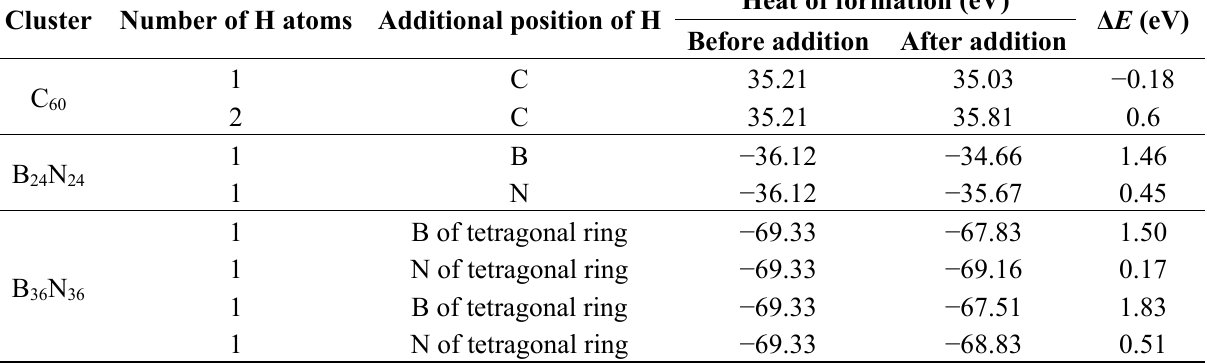
Table 3. Chemisorption energy of hydrogen (H) atoms on C 60 and B 24 N 24 . Δ E = (Heat of formation after hydrogen addition) − (Heat of formation before hydrogen addition).